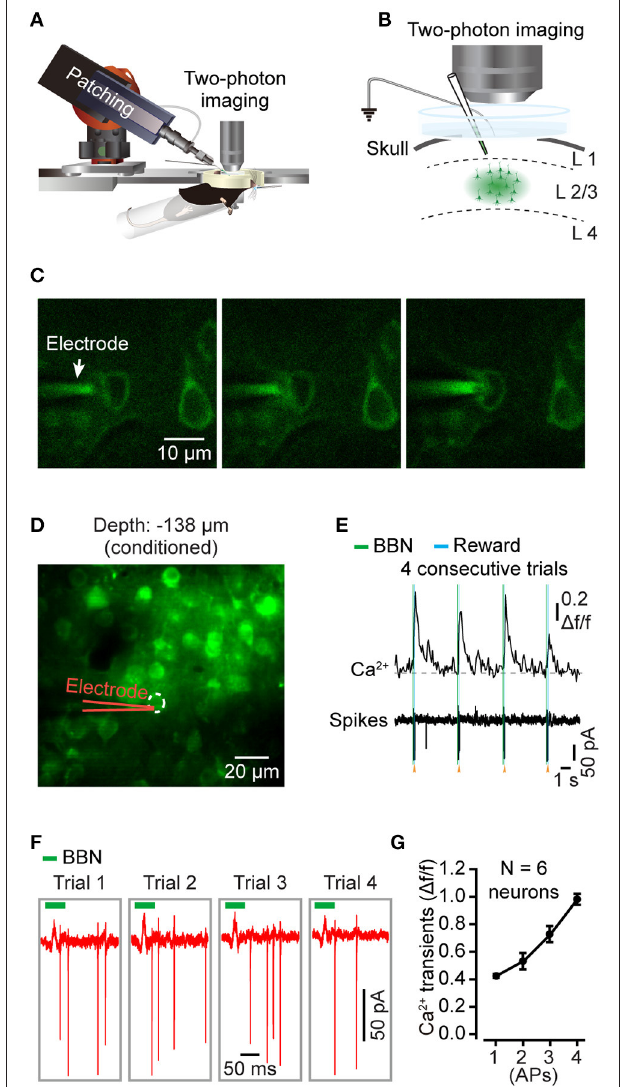
FIGURE 4 | Targeted cell-attached recording of single neurons in the Au1 of behaving mice . (A) Schematic of cell-attached recording in the Au1 of behaving mice. (B) Zoomed in of the targeted cell-attached recording among neurons labeled by bolus loading in layer 2/3 of the Au1. The electrode was filled with Cal-520 potassium salt (100 µ M). (C) The process of targeted cell attachment. Left, approaching the targeted neuron. Middle, applying positive pressure to the neuron. Right, sealing the neuron by sucking. (D) Average image (450 frames) of a focal plane in layer 2/3 of the Au1. (E) Four consecutive trials of sound-evoked Ca 2 + transients and the corresponding electrical signals from the neuron indicated in D . (F) Zoomed in of the action potentials (AP) in E . (G) Comparison of the amplitudes of Ca 2 + transients associated with different numbers of APs (46 trials of 6 neurons from 4 mice).